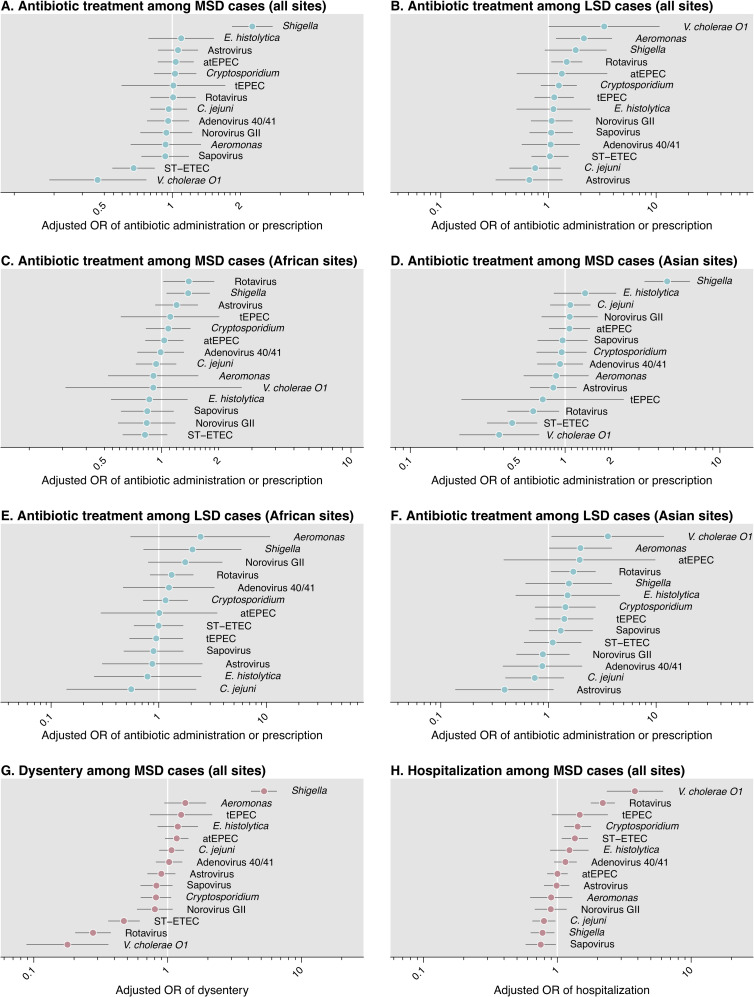
Adjusted association of pathogen with antibiotic prescribing, dysentery, and hospitalization.We illustrate adjusted odds ratios for the association of each pathogen with antibiotic treatment among (A) MSD cases, and (B), LSD cases. We next stratify estimates for the association of pathogen with antibiotic receipt, among MSD cases, by (C) sub-Saharan African sites and (D) South Asian sites, and among LSD cases, by (E) sub-Saharan African sites and (D) South Asian sites. Last, we illustrate the association of each pathogen with (G) dysentery and (H) hospitalization, among MSD cases. Analyses of pathogen presence in MSD define presence as Cq<35 and absence as Cq≥35. Adjusted odds ratios are computed with conditional logistic regression models defining matching strata by country, age (in months), and period (in fortnights); all models further adjust for presence of other pathogens and occurrence of any non-diarrhea diagnosis. Children diagnosed with other conditions justifying antibiotic treatment (lower respiratory tract infection, meningitis or other invasive infection, and typhoid) are excluded from analyses. Lines indicate 95% confidence intervals around (median) point estimates.